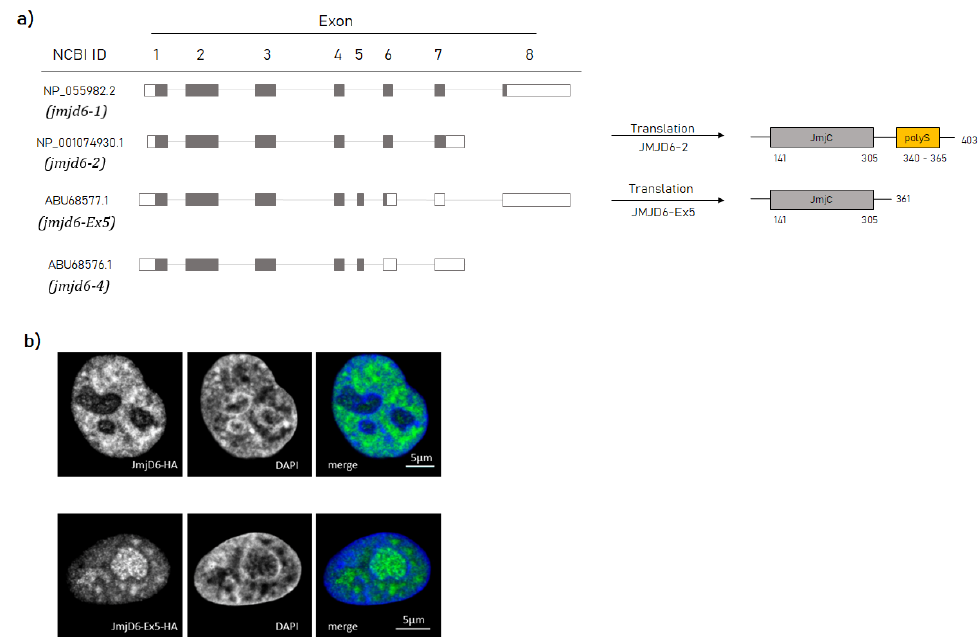
Figure 1. Structural and locational differences between the two isoforms JMJD6-2 and JMJD6-Ex5. ( a ) Comparison of the four annotated jmjd6 transcripts from NCBI (left-hand site). While jmjd6-1 only excludes exon 5, jmjd6-2 excludes exon 5 and 8. In contrast, jmjd6-Ex5 and jmjd6-4 are including exon 5 in their transcripts. This leads to an earlier stop codon in the transcript. However, jmjd6-4 uses an alternative donor site in exon 5 (coding exons are indicated in grey). Comparison of the protein sequence of JMJD6-2 and JMJD6-Ex5 (right-hand site). While both isoforms possess the catalytic JmjC domain (indicated in grey boxes), only JMJD6-2 carries a polyS domain in the C Terminus (indicated as orange box). ( b ) Confocal microscopic single sections of HeLa cells overexpressing JMJD6-2-HA (upper row) or JMJD6-Ex5-HA (lower row). Anti-Hemagglutinin (Anti-HA) tag antibody staining (green) and 4´,6-diamidino-2-phenylindole (DAPI) staining (blue) are shown together as a merged image as indicated. Scale bar: 5 µm.